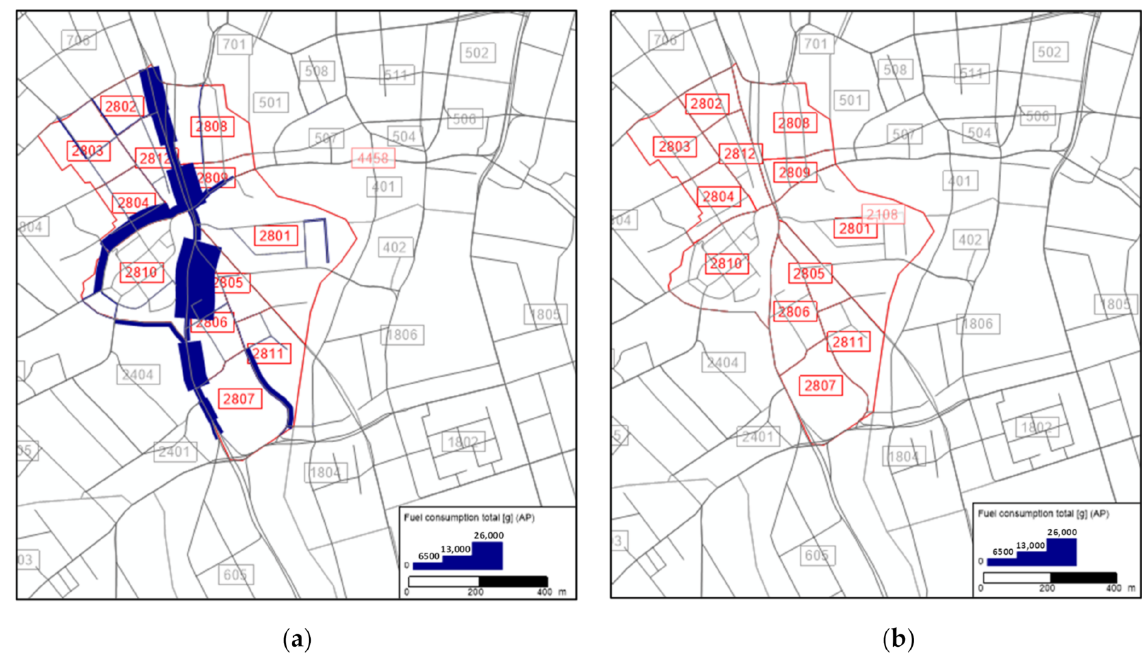
Figure 18. The assessment of fuel consumption total [g] (measure from Group 2) for scenario W0 and optimal scenario (W3)—analysis for the central areas of the city: ( a ) measures for scenario W0; ( b ) measures for scenario W3.